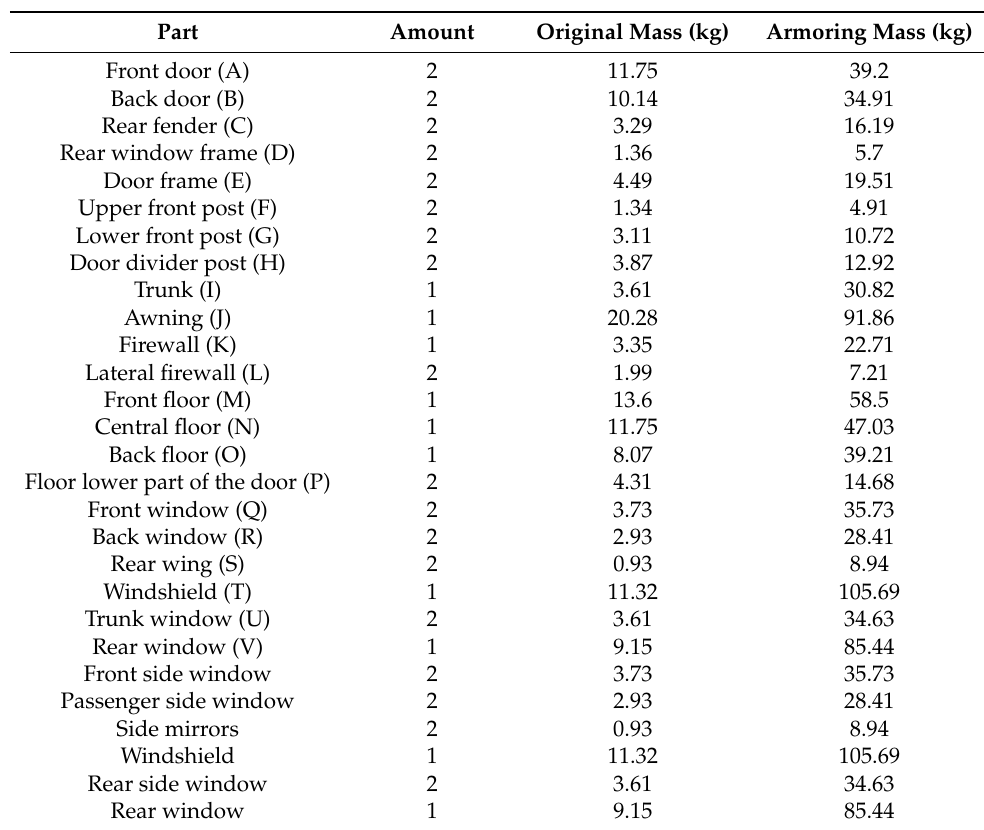
Table 2. Mass change of SUV parts subjected to the armoring